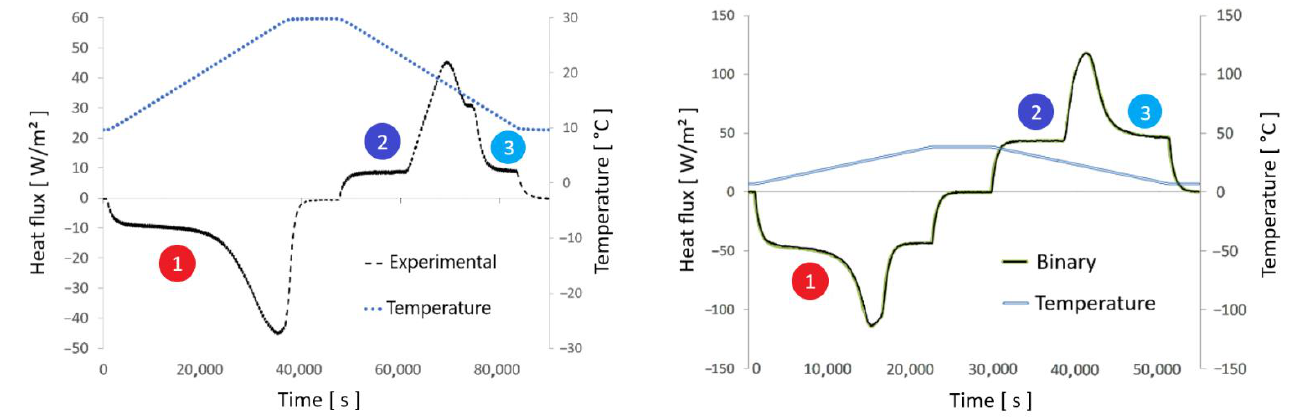
Figure 5. Comparison of the experimental heat flux of the ETMV 8 coating with a binary solution.